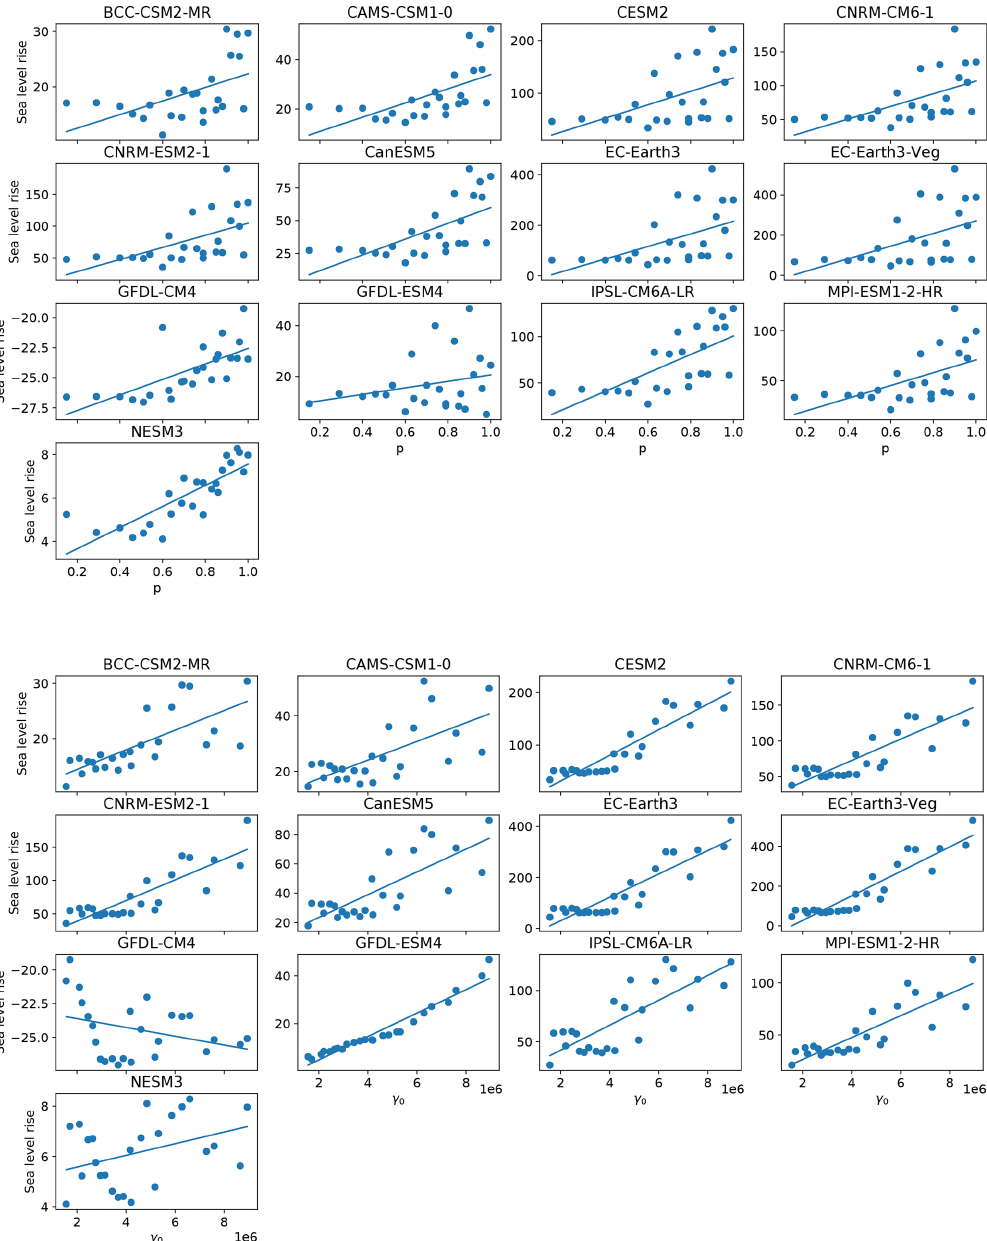
Figure A5. SLR as a function of p and γ 0 in the Amundsen region.